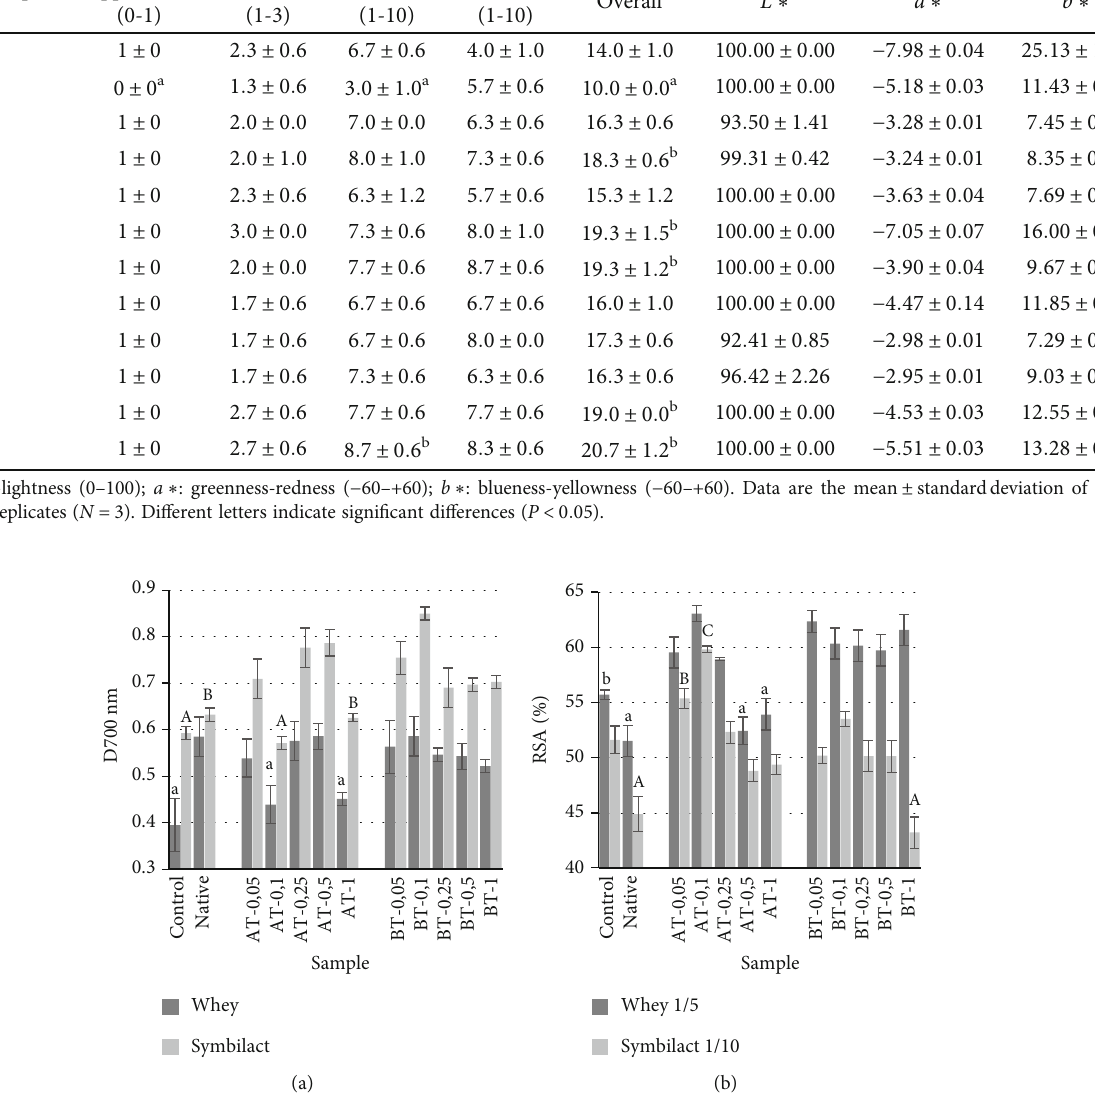
Table 5: Sensory scores and color measurements of Symbilact sample (1-day storage) with added di ff erent starches. Symbilact